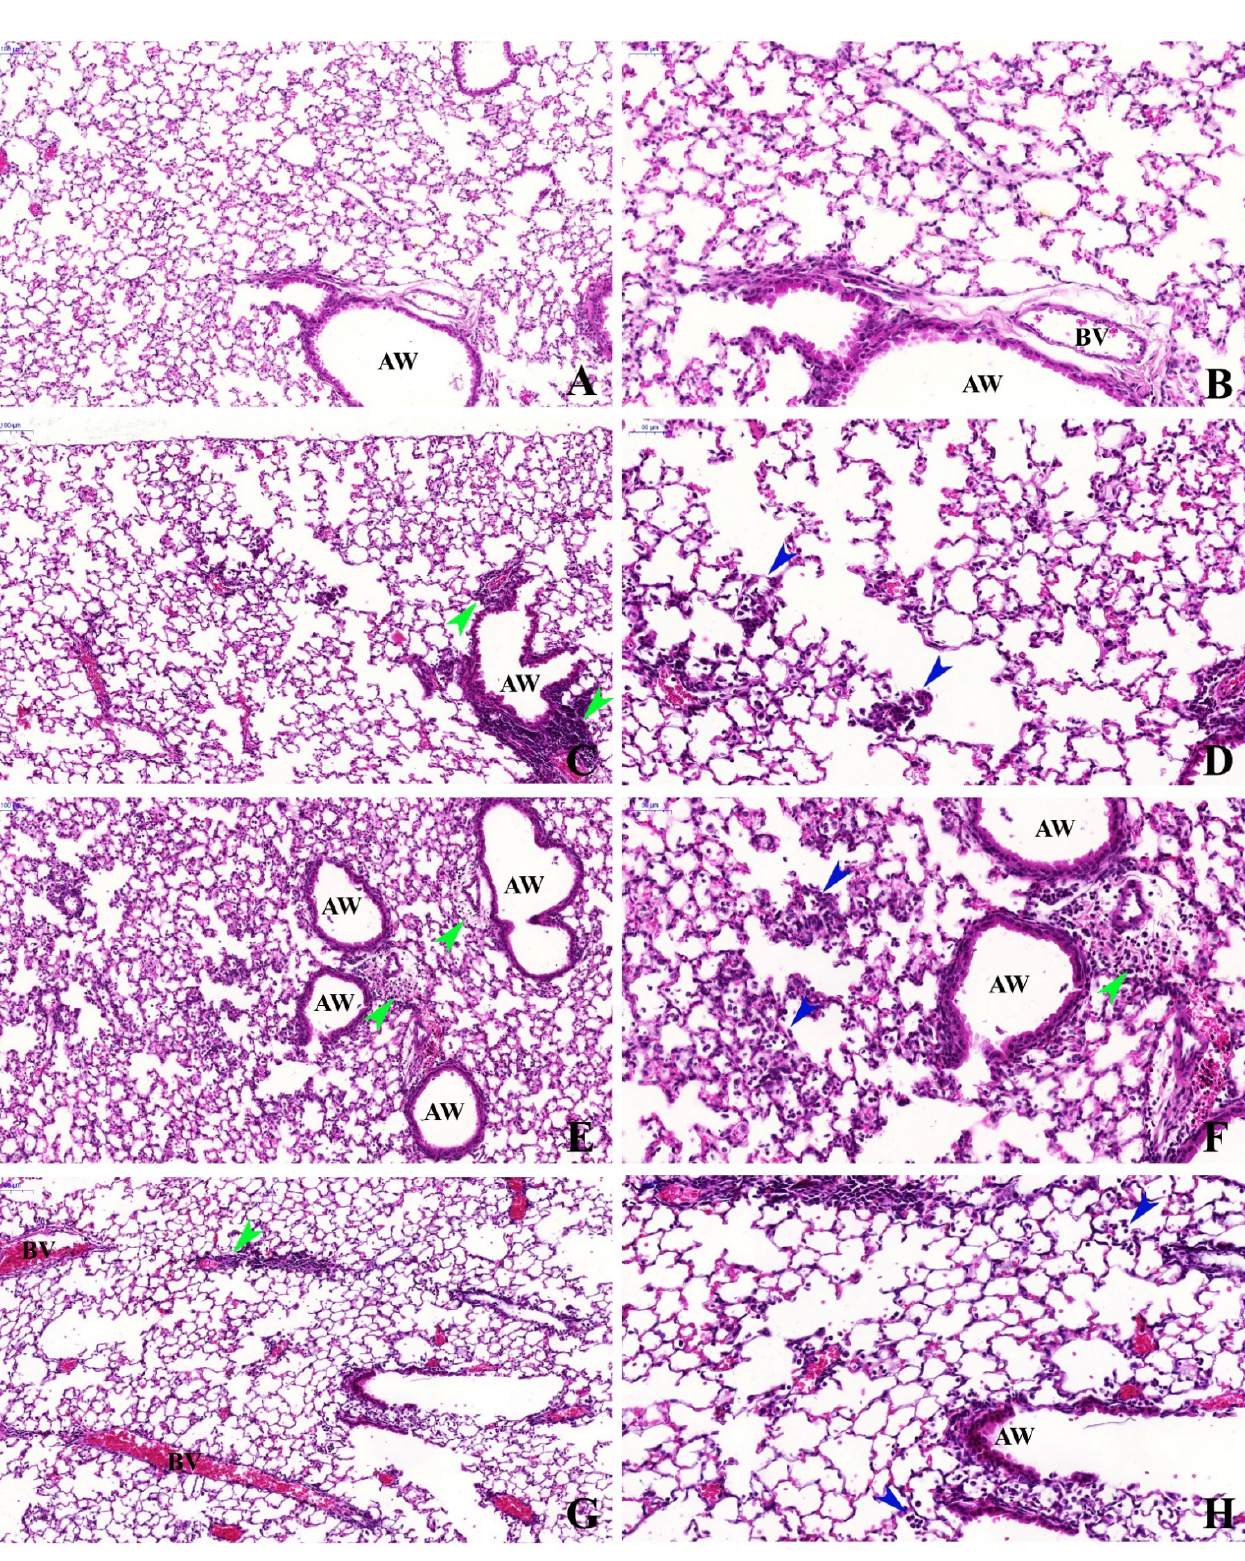
Figure 1. Representative photomicrographs of lung tissue (H&E staining). Control group: ( A ) 10× and ( B ) 20×, thin alveolar septa and no significant inflammation. PM group: ( C ) 10× and ( D ) 20×, inflammatory infiltrate alongside the bronchovascular bundle and mild presence of inflammatory cells in the alveolar space. LPS group: ( E ) 10× and ( F ) 20×, septal thickening and intense inflamma- tory infiltrate in the alveolar space and adjacent to the airways and blood vessels, with a predomi- nance of polymorphonuclear cells. PM+LPS group: ( G ) 10× and ( H ) 20×, septal thickening, peri-